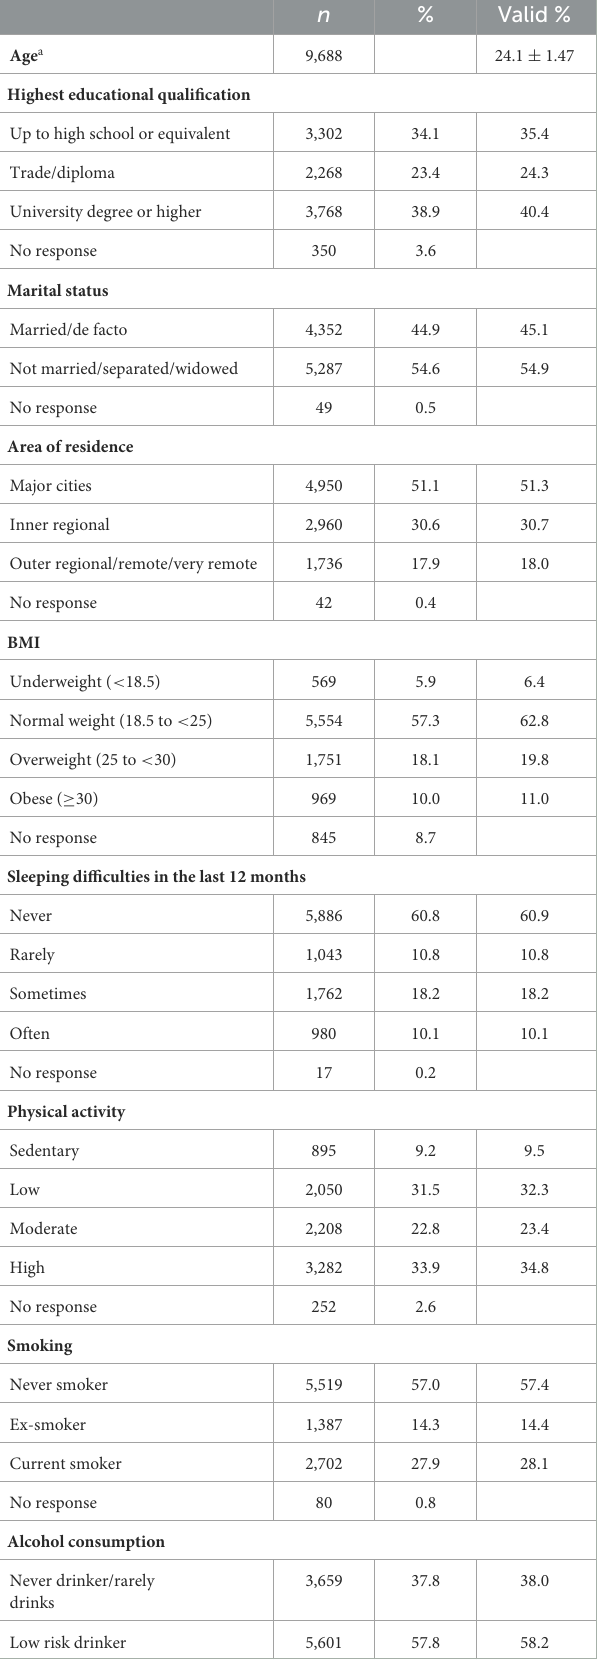
TABLE 1 Sample characteristics in 2000 ( n =